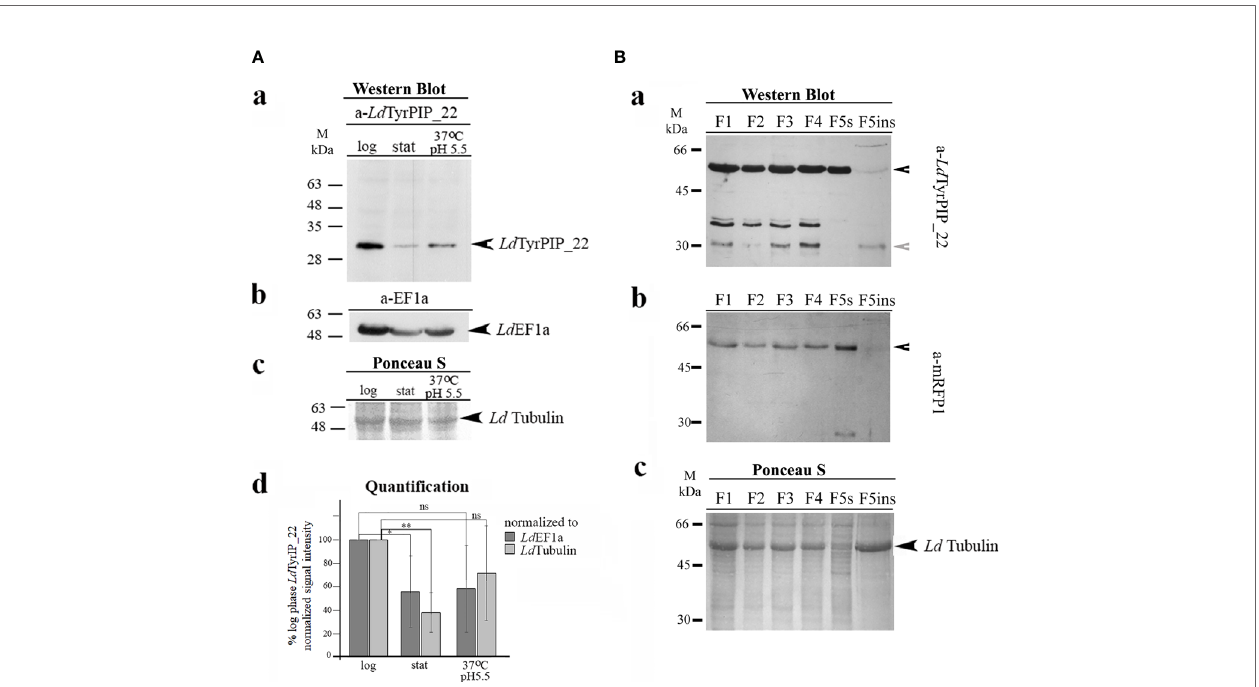
FIGURE 4 | Biochemical detection of the endogenous Ld TyrPIP_22 forms in wt L. donovani (LG13) and in L. donovani - ldtyrpip _ 22 -mrfp1 transgenic promastigotes. Subcellular distribution of Ld TyrPIP_22 by detergent treatment. (A) Total lysates (40 m g protein/well) from logarithmic (log) and stationary (stat) phase cultures of promastigotes (~5X10 6 cells), as well as from parasites after treatment of stationary phase promastigotes for 24 h at 37°C and pH 5.5, were analyzed by SDS-PAGE (12% w/v) and immunoblotted with the puri fi ed rabbit a- Ld TyrPIP_22 pAb (2 m g/ml) (a). The membrane was then rebloted after stripping with the a-EF1a mAb (1:10,000). Ld EF1a was used as loading indicator (b). The region of the membrane with tubulin stained with Ponceau-S is shown (c) as a 2 nd loading indicator. (d) Quanti fi cation of the intensity of the Ld TyrPIP_22 band signal for each condition was performed using the Fiji algorithm. The intensity of the Ld TyrPIP_22 band signal for each condition was normalized to the intensity of the corresponding Ld EF1a or Ld Tubulin band signals and expressed as % of the normalized Ld TyrPIP_22 signal at the logarithmic phase in each experiment. The mean values from three independent experiments with standard deviations were plotted. ** (P ≤ 0.01), * (P ≤ 0.05) and ns (P > 0.05). (B) Protein fractions (F1-F5ins) from stationary phase L. donovani - ldtyrpip _ 22 -mrfp1 transgenic promastigotes, produced by permeabilization of total cell pellet with digitonin and Triton X-100 ( Materials and Methods ) were analyzed by SDS-PAGE (12% w/v) and immunoblotted with the mouse a- Ld TyrPIP_22 serum (1:1,200) (a) and subsequently, after stripping, with the puri fi ed a-mRFP1 (0.5 m g/ml) pAb (b). Ponceau-S of respective membrane regions (c), is shown as loading indicator. Black arrowhead indicate the protein bands corresponding rabbit to r Ld TyrPIP_22-mRFP1 and grey arrowhead to band assigned to the endogenous Ld TyrPIP_22. Molecular weights are indicated in